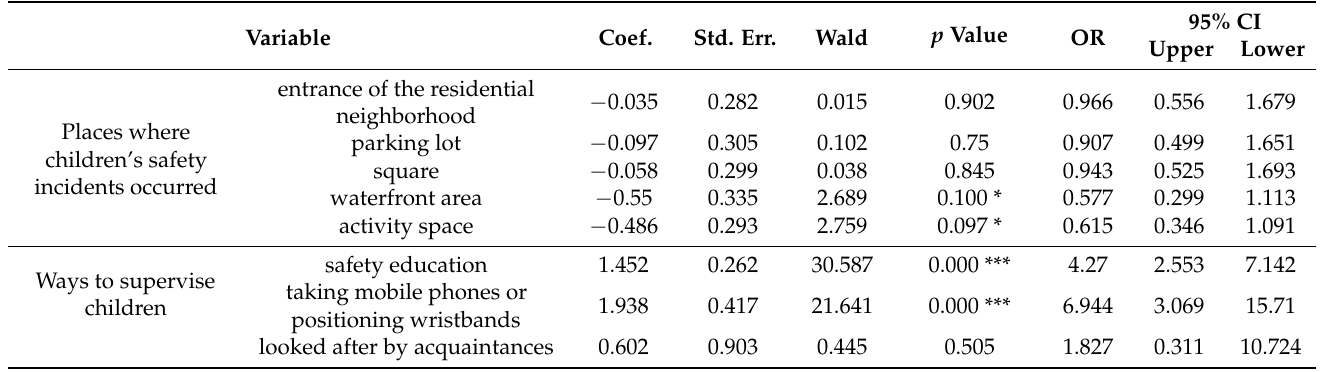
Table 7. Binary Logistic Regression Analysis of guardians on CIAs